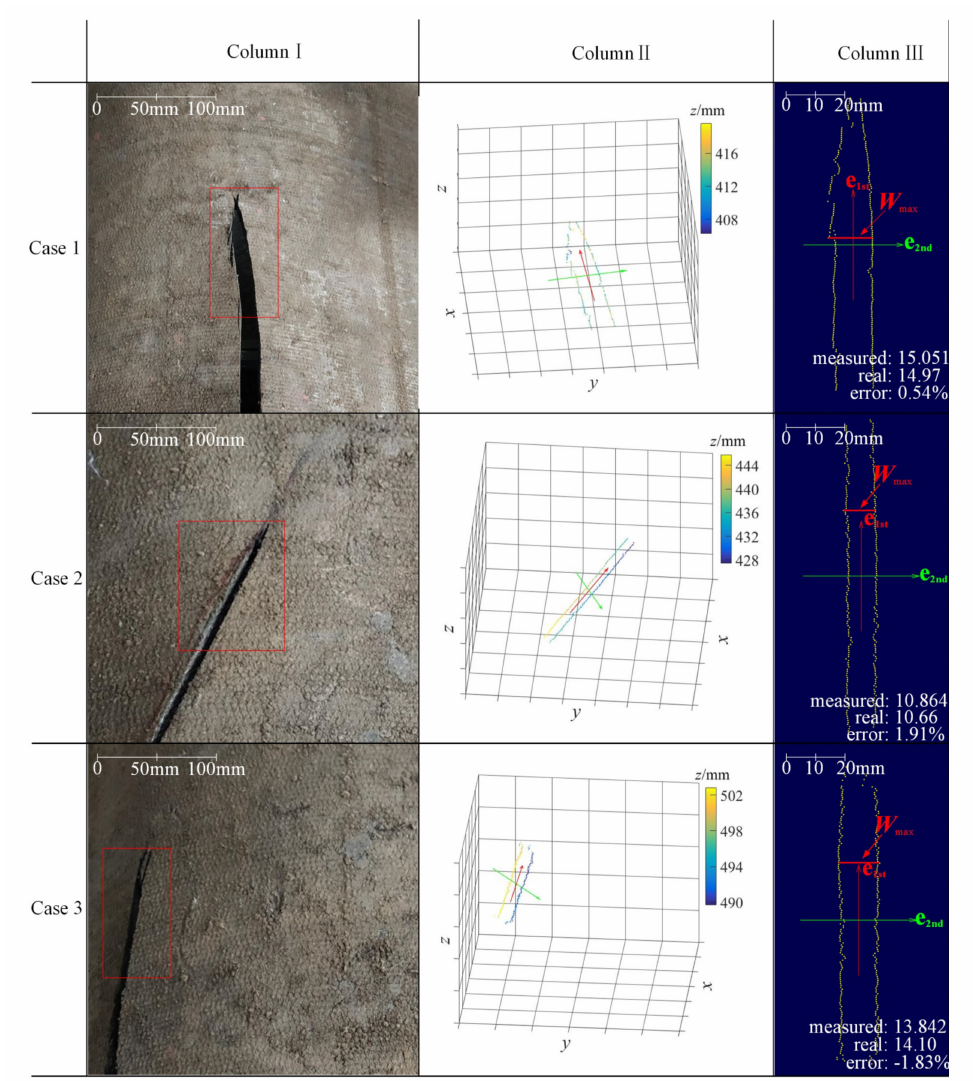
Figure 9. The experimental results; column I: physical pictures; column II: the 3D visualization of the rip edge points, the color bar corresponds to the z coordinate values; column III: the calculation result visualization of max width of each